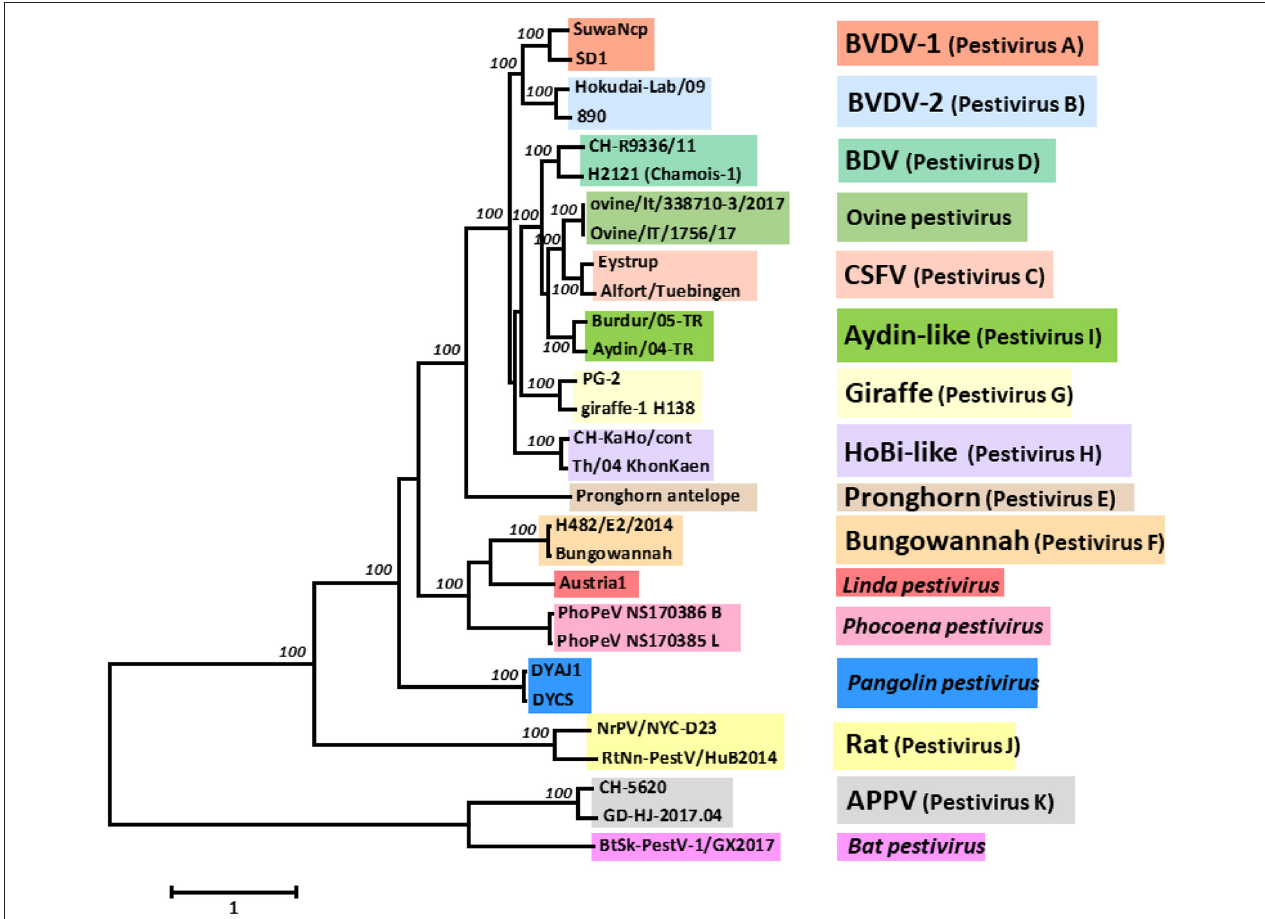
FIGURE 1 | Phylogenetic analysis and classification of pestiviruses based on the nucleotide sequence of the entire open reading frame (ORF). The evolutionary history was inferred using the Maximum Likelihood method based on the General Time Reversible model (16), with the tree with the highest log likelihood being shown. A discrete gamma distribution was used to model evolutionary rate differences among sites. The percentage of replicate trees in which the associated taxa clustered together in the bootstrap test (100 replicates) are shown next to the branches ( 17), with only maximal values of 100 being shown. The tree is drawn to scale, with branch lengths measured in the number of substitutions per site. The analysis involved 29 nucleotide sequences. Codon positions included were 1st + 2nd + 3rd + non-coding. All positions with < 95% site coverage were eliminated. There were a total of 9,912 positions in the final dataset. Evolutionary analyses were conducted in MEGA7 (18). The GenBank accession numbers of the sequences used are listed in Supplementary Table 1